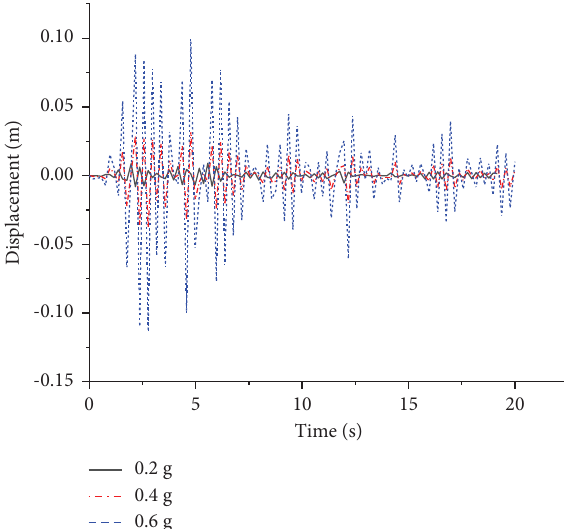
Figure 20: Displacement time-history curves of El Centro wave under diferent modulated amplitudes.